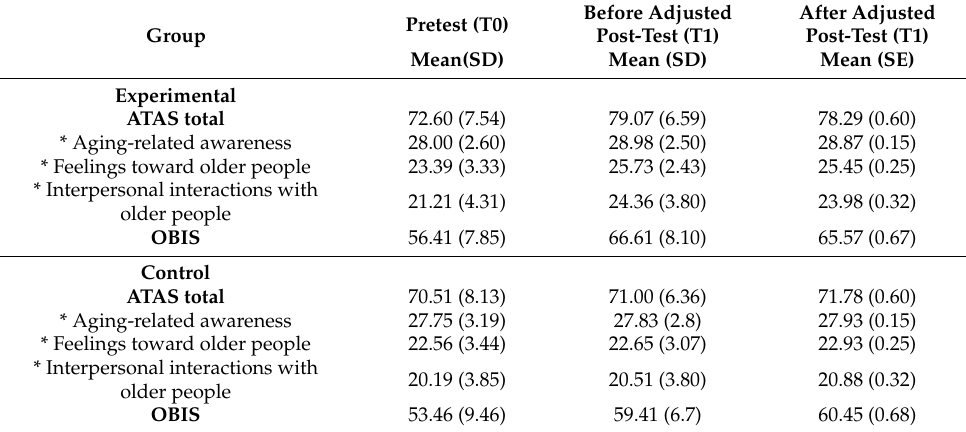
Table 5. Adjusted post-test score averages of the two